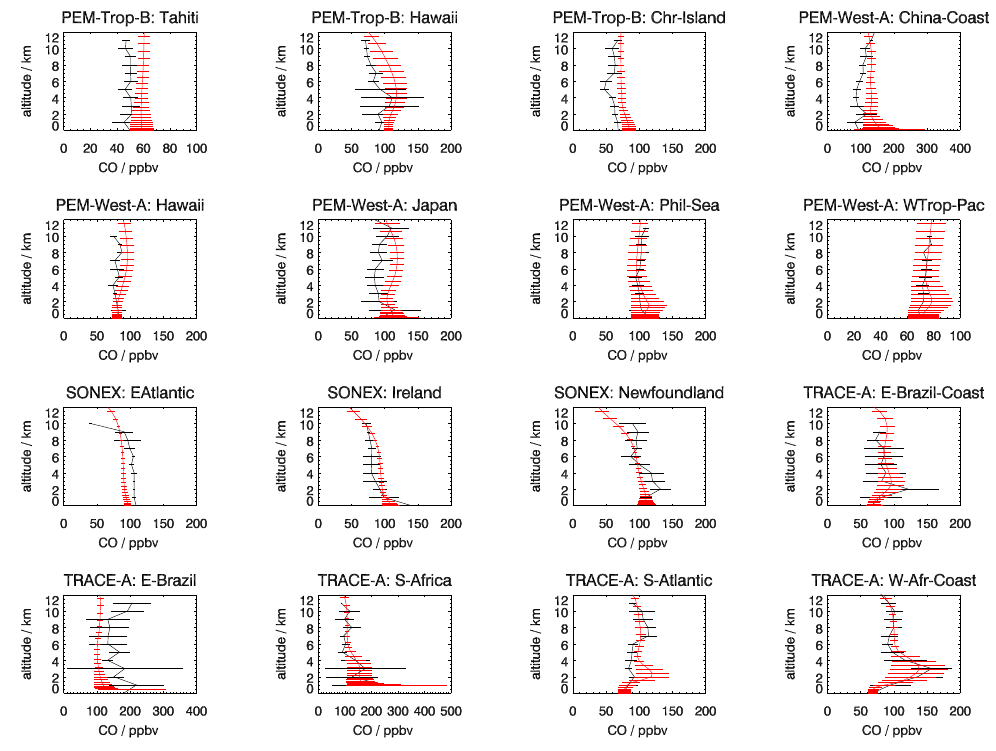
Fig. 17. Comparison between regional vertical profiles of modelled (red) and observed (black) CO from various aircraft campaigns compiled into data composites by Emmons et al. (2000). In each case, the mean concentration in each altitude bin is plotted and the horizontal lines represent the mean ± 1 standard deviation.